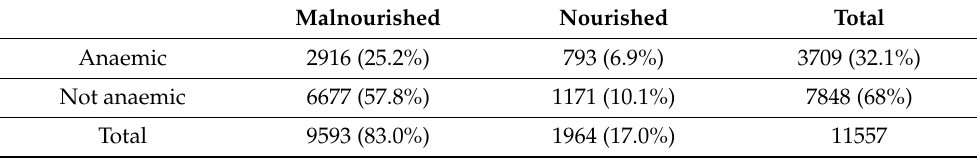
Table 1. Characteristics of the sample according to anaemia and malnutrition status.